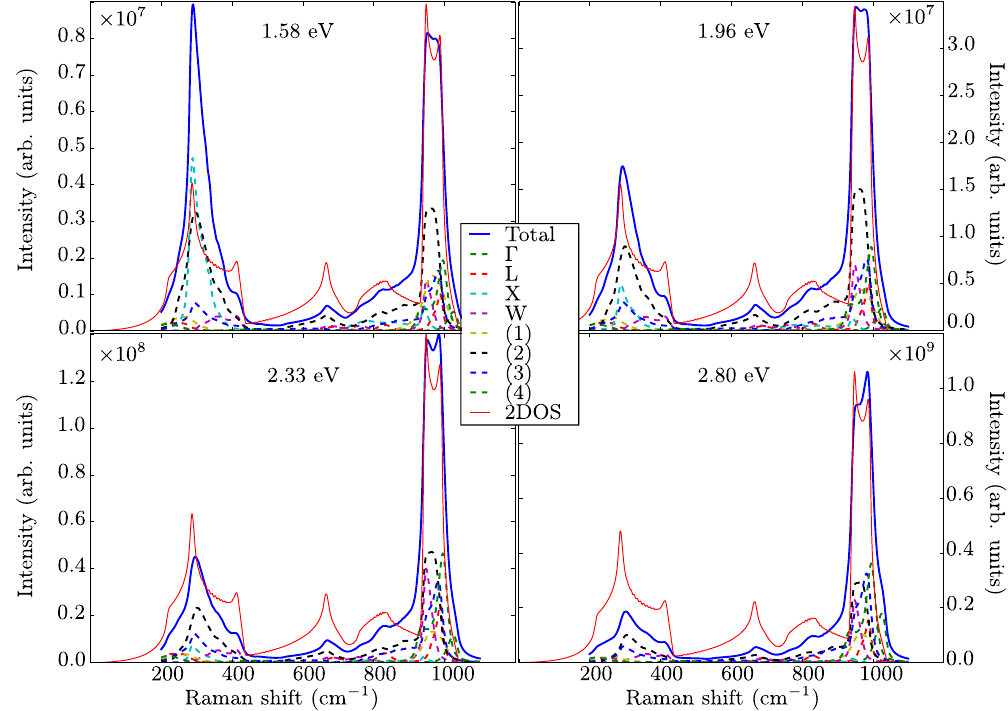
Figure 5. Diagonal component of the second-order Raman spectrum obtained in the IPA (blue lines), and its  : 1.58 eV, 1.96 eV, 2.33 eV and 2.80 eV. Eight wavevector decomposition for four different excitation energies ω L q wavevectors are considered, in reduced coordinates: Γ = (0, 0, 0), L = (1/2, 1/2, 1/2), X = (1/2, 1/2, 0), W = (1/4, 1/2, 3/4), (1) = (1/4, 1/4, 0), (2) = (1/2, 1/4,0), (3) = ( − 1/4, 1/4, 0), (4) = 1/4, 1/4, 1/4). The two- phonon density of states is also represented for sake of comparison (red